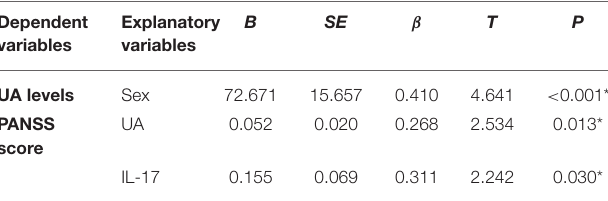
TABLE 4 | Results of multiple regression analysis with serum UA levels and total PANSS score in all psychotic patients after therapy as dependent variables and demographic and clinical data as explanatory